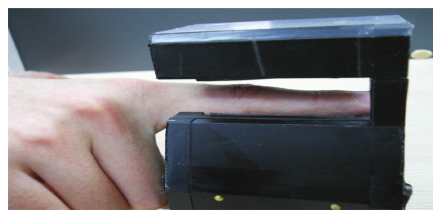
Figure 4: The finger vein capture